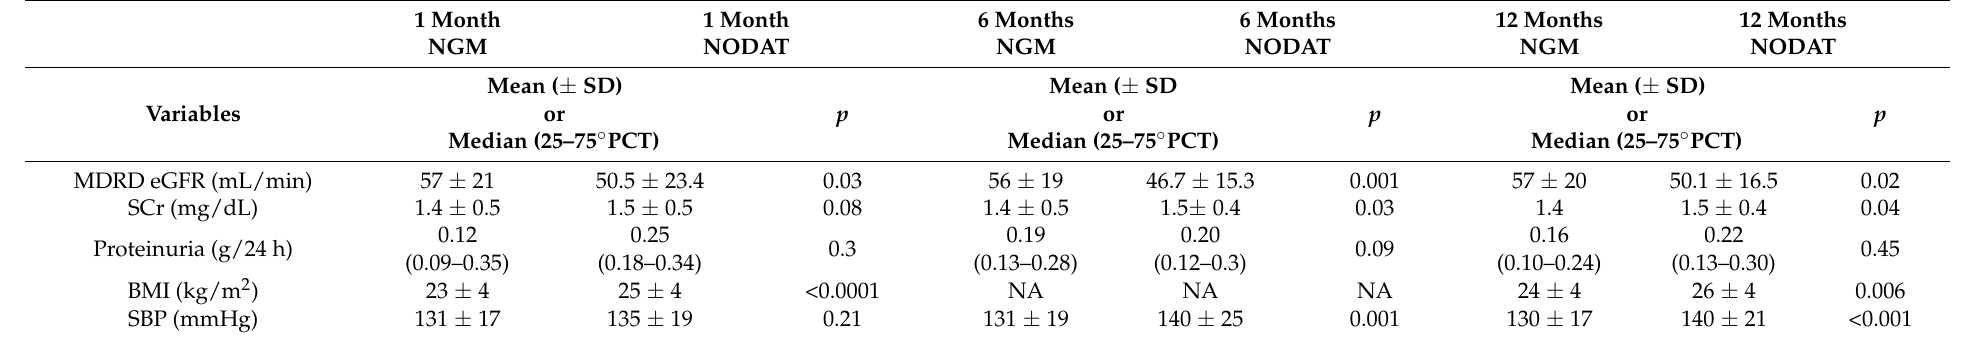
Table 3. Clinical and laboratory parameters at one-, six-, and 12-month follow-up of kidney transplant recipients with normal glucose metabolism (NGM) or new-onset diabetes mellitus after transplantation